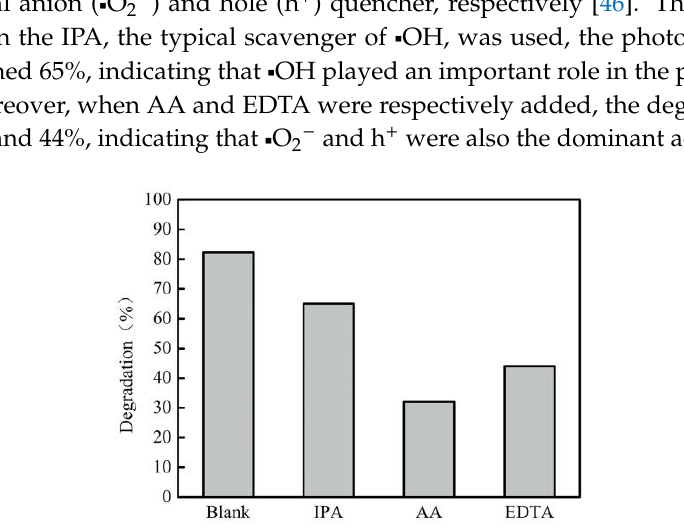
Figure 8. Photodegradation rates of naphthalene in the presence of different scavengers (IPA- isopropanol, AA-ascorbic acid, EDTA-ethylenediamine tetraacetic